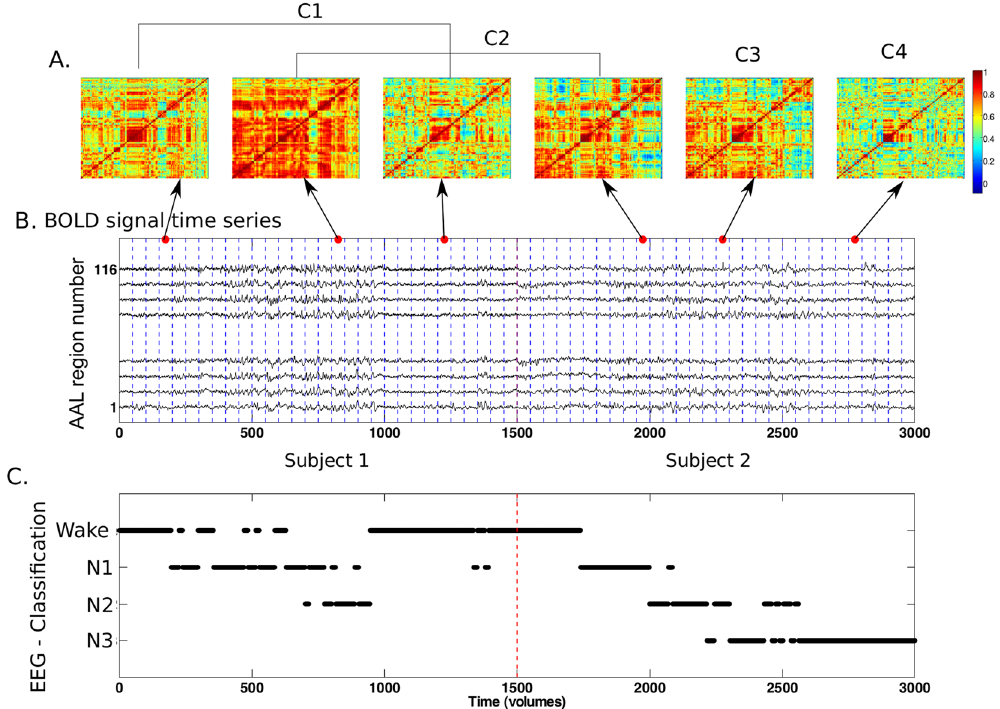
Figure 1. Definition of dynamic connectivity states. ( A ) We obtained correlation matrices for each window by computing the pairwise correlation coefficient between the blood oxygenation level-dependent (BOLD) signal time series for all 116 AAL template regions (example signals from two typical participants are presented in panel B). We applied k-means clustering to matrices from all subjects to divide them into dynamic connectivity states (in this example, arrows indicate time windows belonging to four different clusters, C1, C2, C3 and C4). ( C ) Assignment of each time window to a sleep stage following sleep scoring of the simultaneously acquired EEG data based on AASM scoring rules 32 for two exemplary concatenated subjects. The time axis is presented in scan volumes, 1500 volumes correspond to 52 min of scanning (time of repetition: 2.08